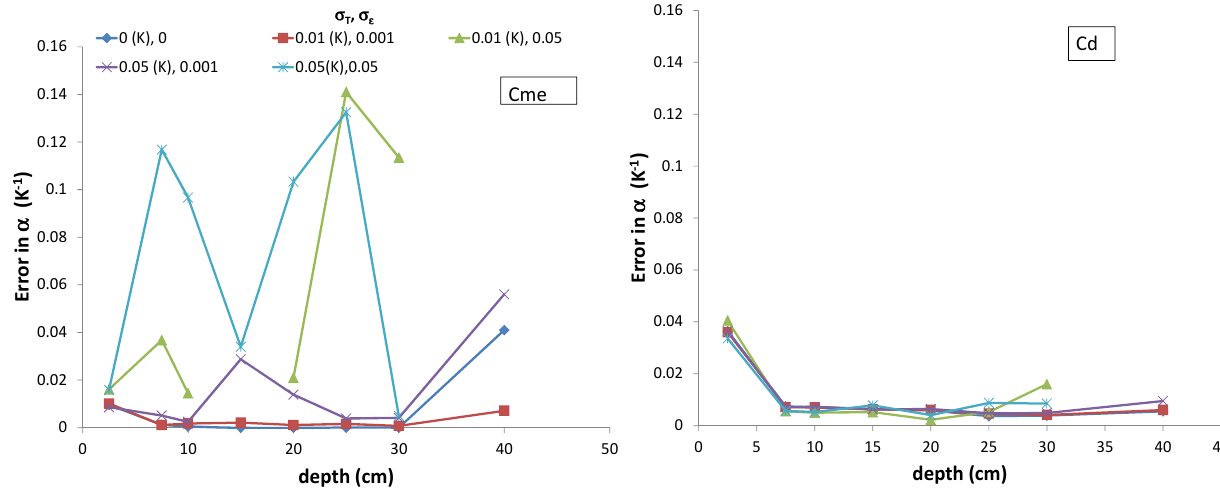
Figure 5. Error in α as a function of depth considering the Cme and Cd methods. Different measurement error scenarios given in the legend for temperature ( σ permittivity ( σ ) are ε